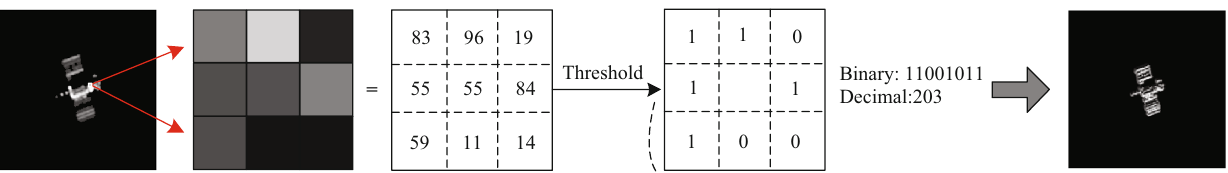
Figure 8: Original LBP operator.